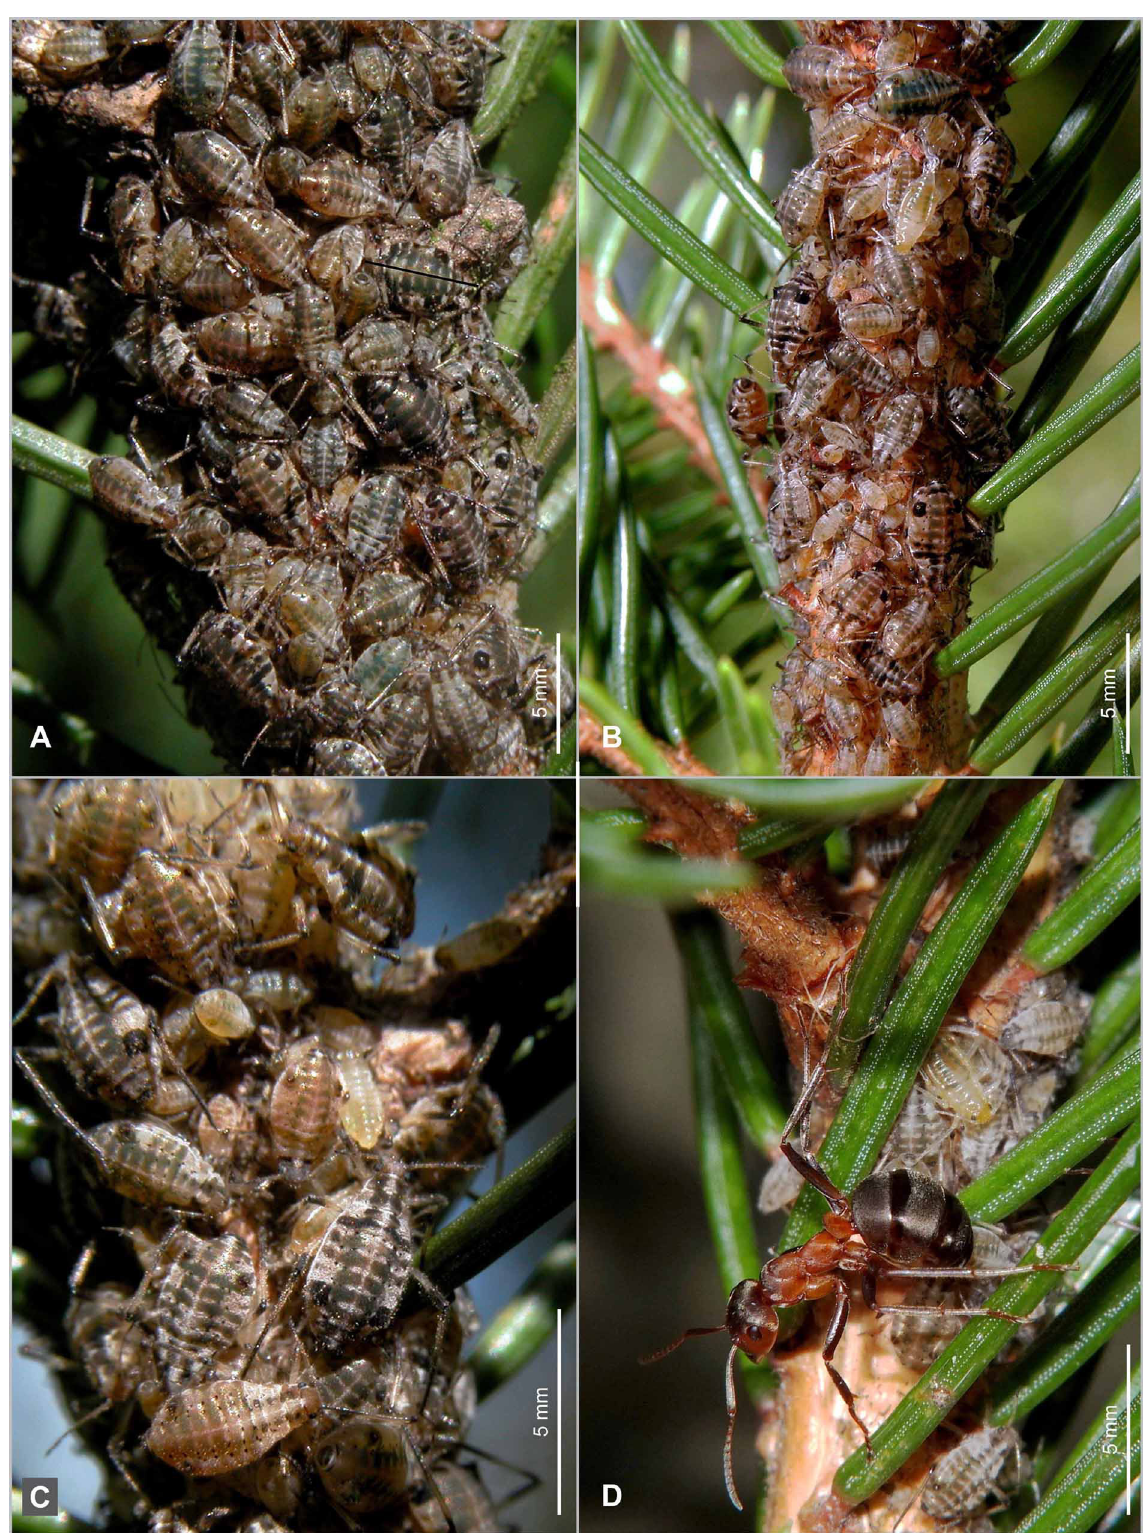
Fig. 35. Cinara (Cinara) pruinosa (Hartig, 1841). Colony on underside of branch of Picea abies , attended by Formica aquilonia Yarrow, 1955 (D). Adult apterae, juvenile apterae and